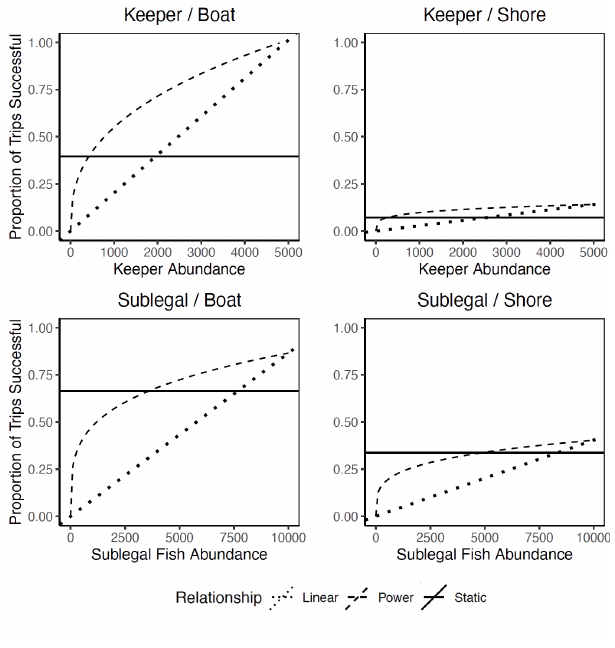
Fig. 3 . The three types of abundance-catch relationships tested, split by fish size (keeper or sublegal) and method of fishing (boat or